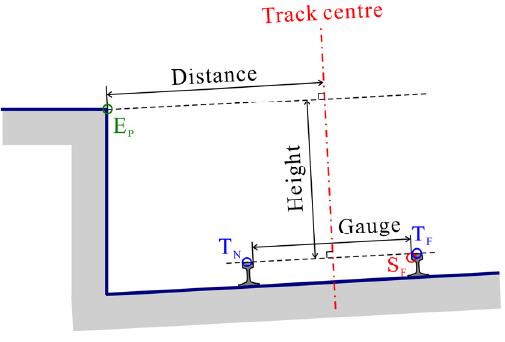
Figure 6. Clearance of a platform